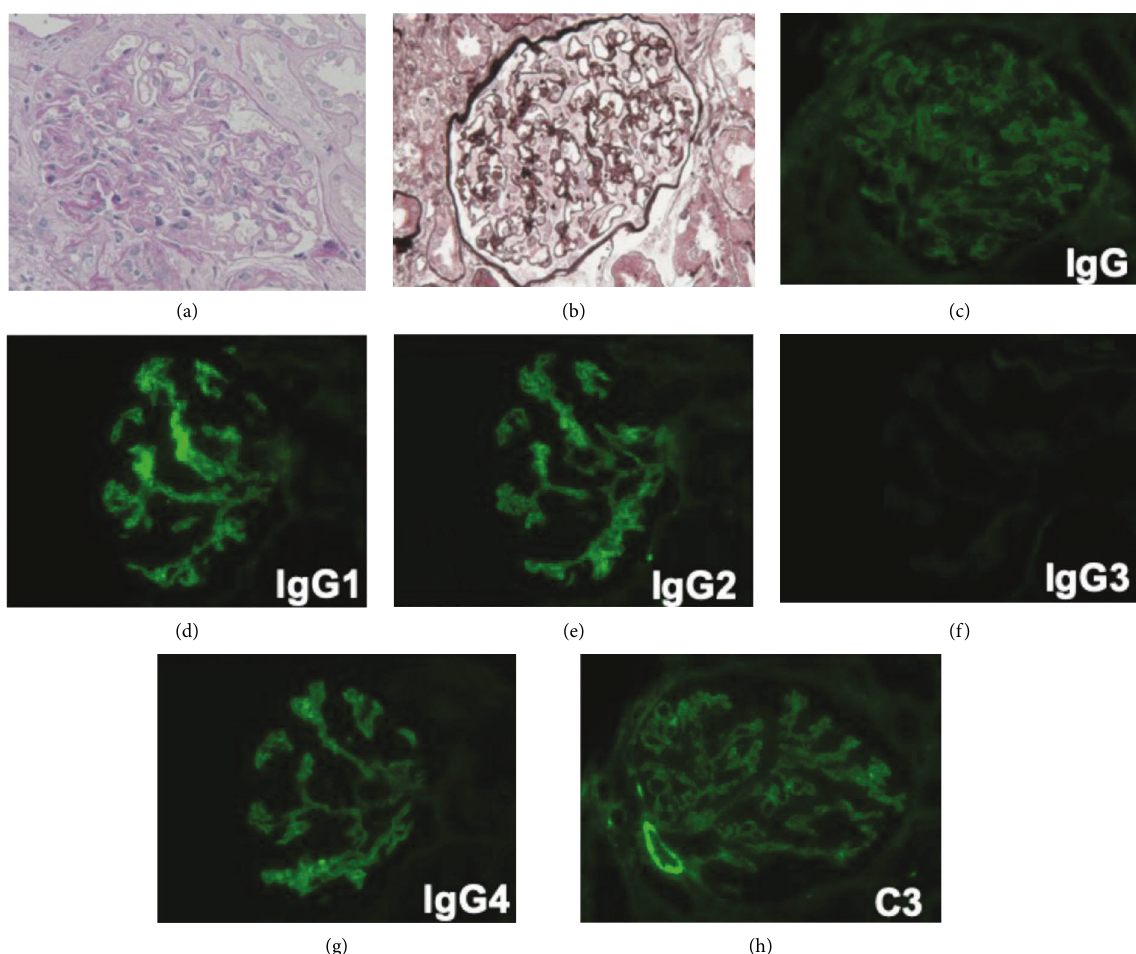
Figure 3: Renal biopsy showing deposition of immunoglobulin G (IgG) and complement 3 (C3) in a woman who developed recurrent anti- glycyl tRNA synthetase (EJ) antibody-positive dermatomyositis concurrently with newly developed nephrotic syndrome. (a) Hematoxylin and eosin (HE) stain; (b) periodic acid methenamine silver (PAM) stain; immunofluorescence examination: (c) total IgG; (d) IgG1; (e) IgG2; (f) IgG3; (g) IgG4; (h) C3. Light microscopic examinations using HE and PAM stains show neither thickening nor spike formation of basement membranes. Deposition of IgG, IgG1, IgG2, IgG4, and C3 is noted. Immunoglobulin A (IgA) and immunoglobulin M (IgM) are absent (data not shown).